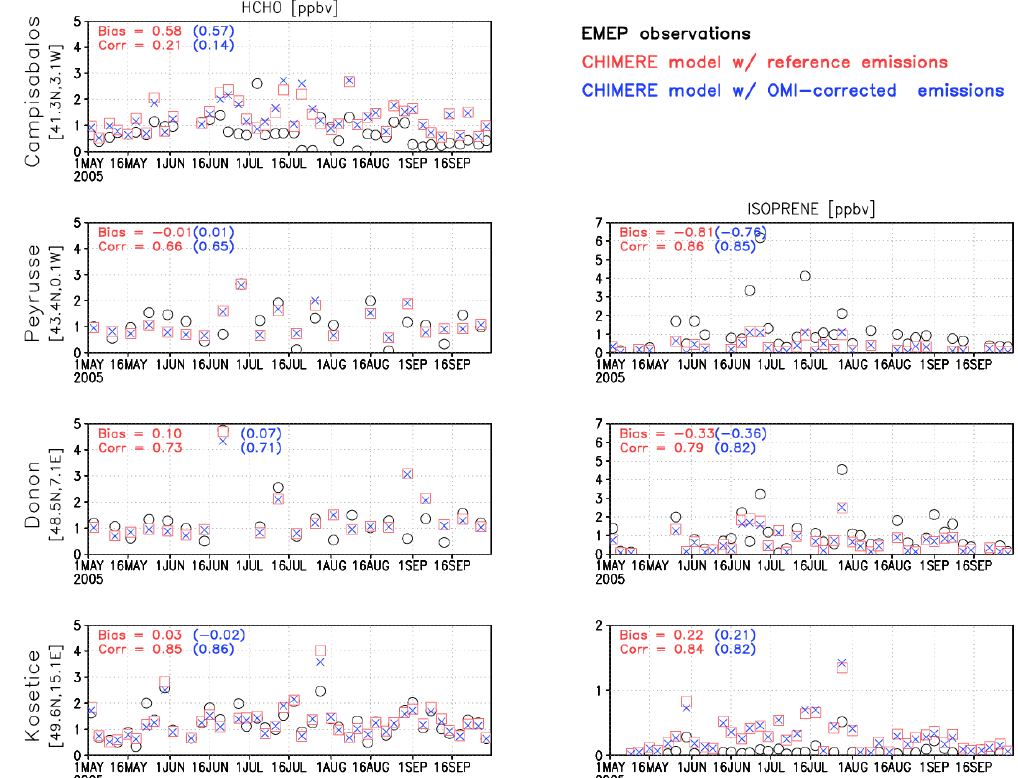
Fig. 1. Comparison of EMEP surface measurements of HCHO (left) and isoprene (right) (black circles) with the CHIMERE model dur- Fig. 2. Comparison of OMI and model monthly mean HCHO columns (10 15 molecules cm − 2 ) during ing May–September 2005 with standard (a-priori) emissions (red squares) and with OMI-corrected (a-posteriori) emissions (blue crosses). Latitude and longitude of monitoring stations, and bias and correlation of model results with respect to observations are shown inset. May–September 2005. OMI columns are mapped onto the same 0.5 ◦ × 0.5 ◦ grid of the model with daily frequency, with the model sampled at the time and location of OMI observations. 3 Formaldehyde column distributions over